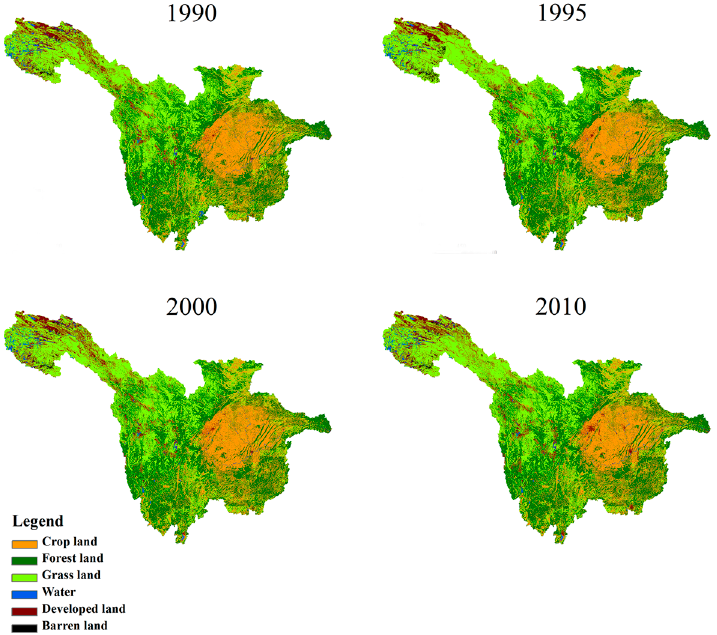
Figure 6. Historical LULC maps in the study area: 1990, 1995, 2000, and 2010. Table 4. Area of each LULC type based on historical LULC maps (unit: ×10 4 km 2 ).